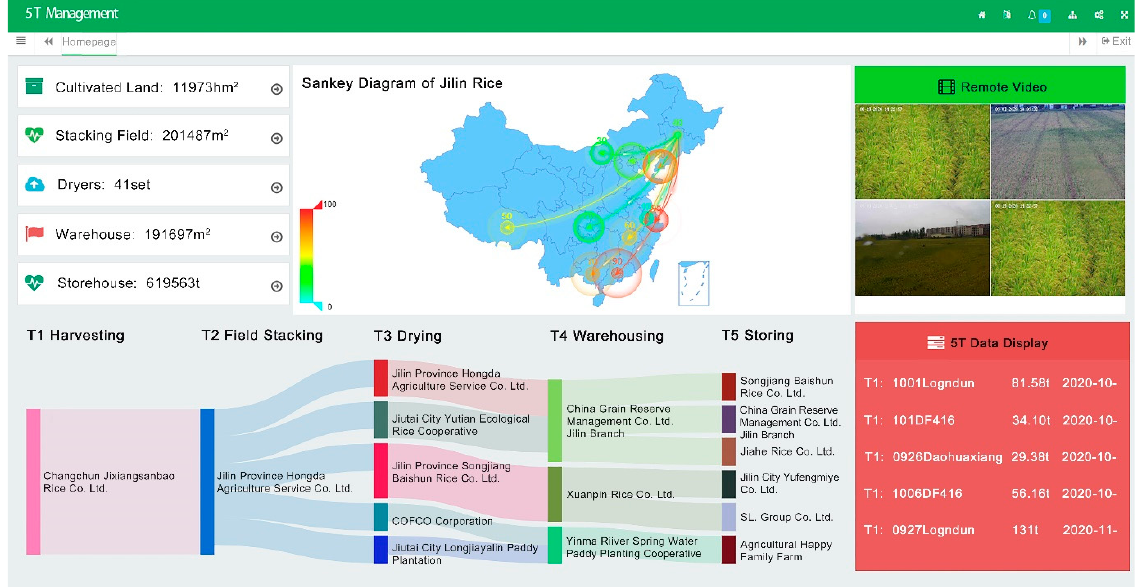
Figure 14. The interface of Agricultural Production Data Management System.